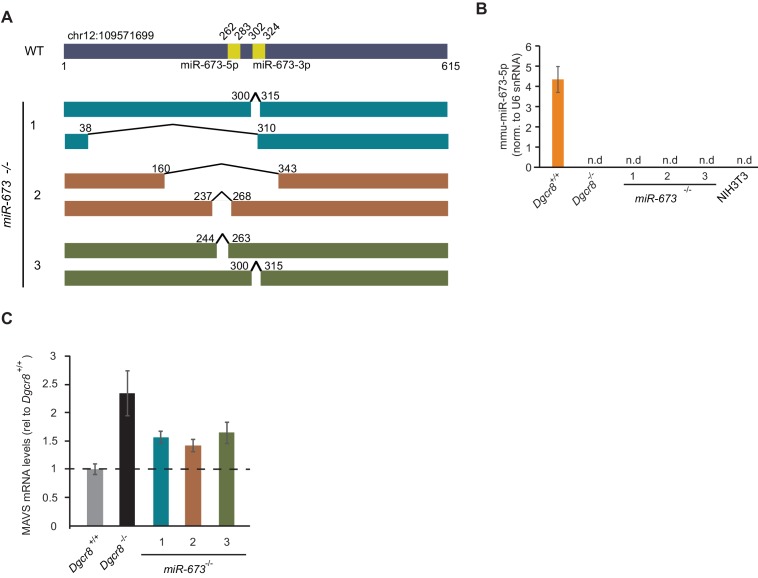
Characterization of miR-673-/- mouse embryonic stem cells.(a) Genomic sequencing of miR-673 locus contained in chromosome 12. In WT, the position of the two miRNAs encoded by the locus, miR-673–5p and miR-673–3p are indicated by yellow boxes. For miR-673-/- clones (1,2 and 3) both sequenced alleles are shown with the indicated deletions induced by CRISPR. (b) Quantification of mmu-miR-673–5p abundance by qRT-PCR. Data show the average (n = 3)±s.d, normalized to U6 snRNA. (n.d, not detected) (c) Quantification of Mavs mRNA levels by RT-qPCR. Data show the average of at least (n = 3)±s.d, normalized to Actb, and relative to Dgcr8 +/+.